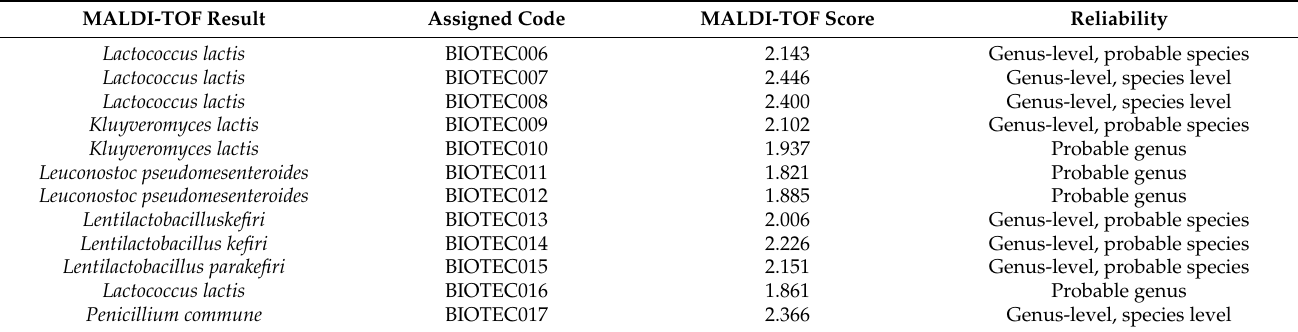
Table 1. MALDITOF-MS identification of kefir microorganisms with software reliability scores a .